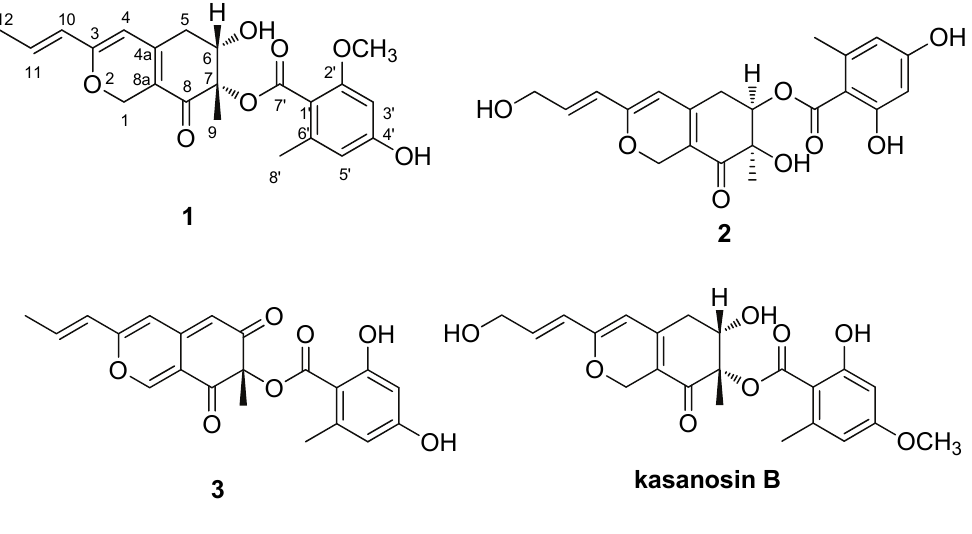
Figure 1. Structures of compounds 1 - 3 and kasanosin